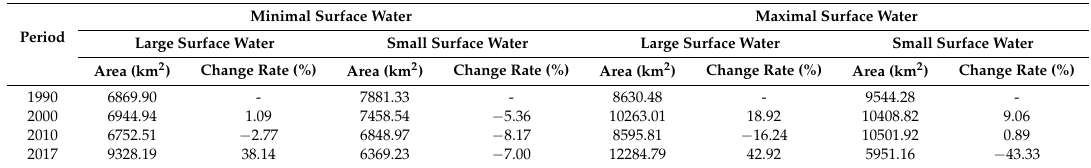
Table 4. Areas and change rates of large surface water and others of minimal and maximal surface water extent in the study periods.